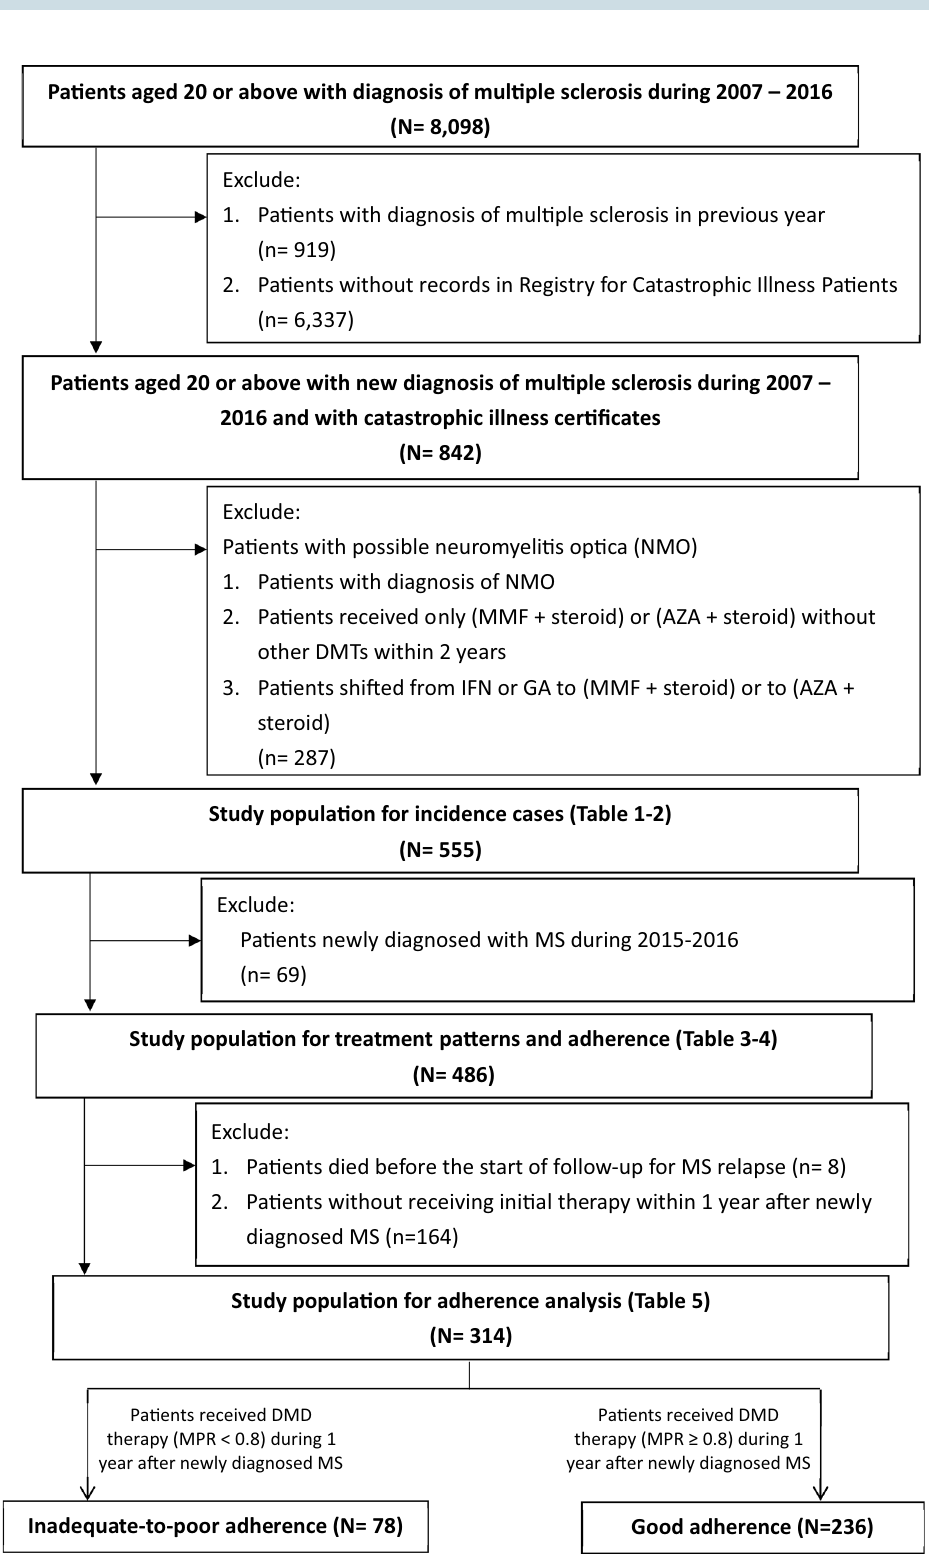
Figure 1. Flow chart describing the enrollment of the study